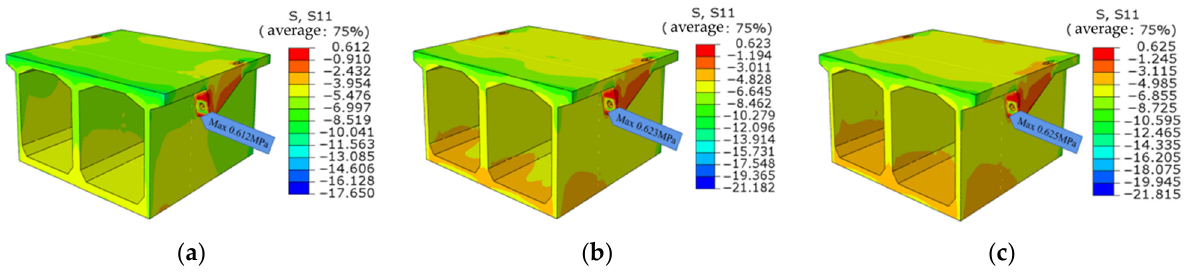
Figure 12. The longitudinal bridge stress diagram of each working condition. ( a ) Initial state; ( b ) A1 cable fracture; ( c ) A2 cable fracture.